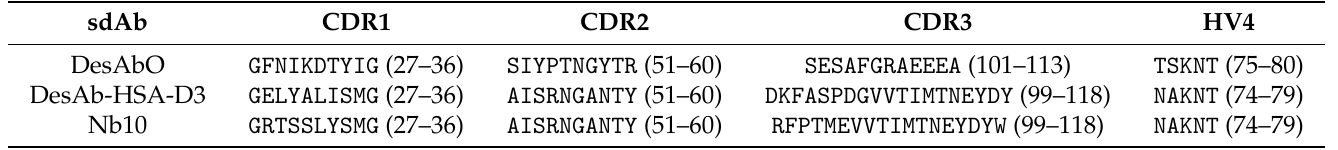
Table 2. Definition of the complementarity-determining regions of the 3 sdAbs studied in this work.